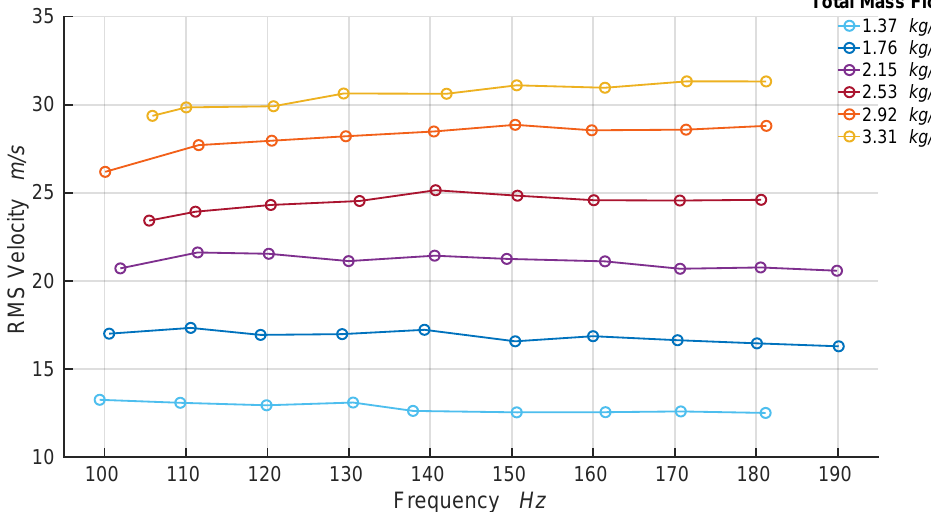
Figure 6. Independent control of frequency and amplitude. The diagram shows the root mean square (RMS) values of the velocity signals at the outlet ports for different actuation frequencies. It demarcates the operational range of the fluidic